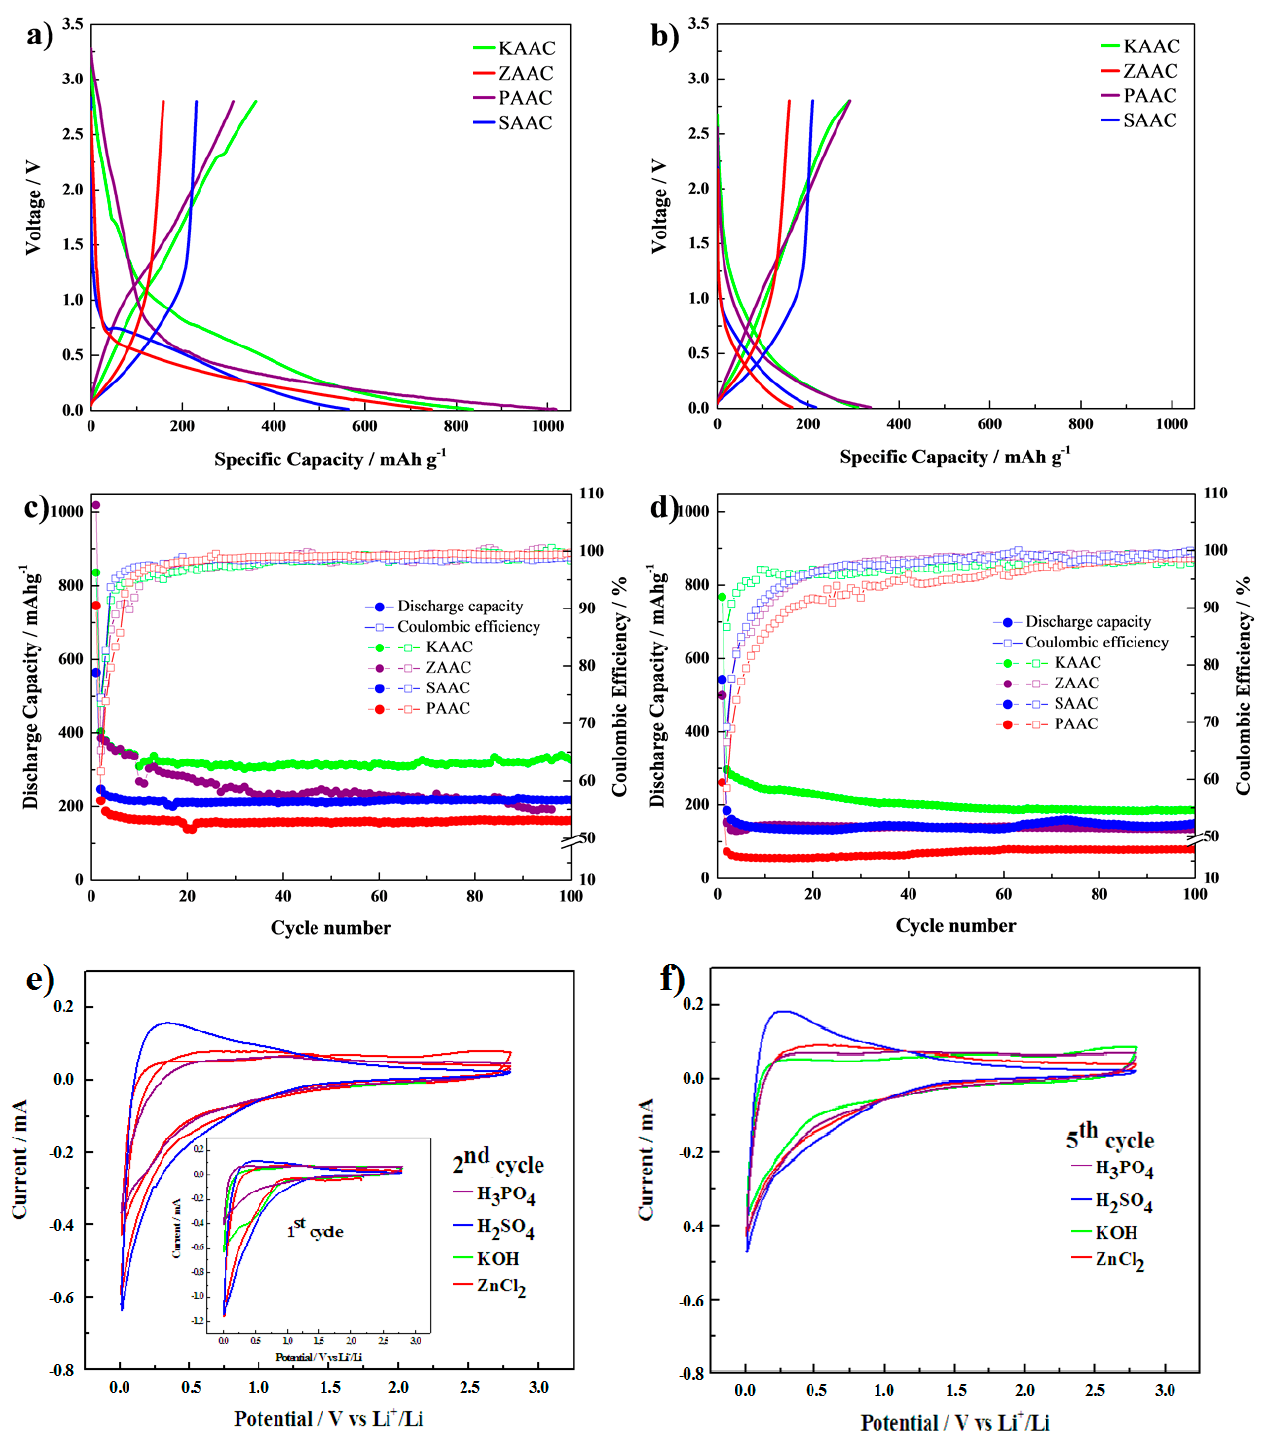
Figure 5. Cycling performances of AC electrodes ( a ) at 1st cycle at 0.1 C rate; ( b ) at 10th cycle at 0.1 C rate. Cycling performance with Coulombic efficiency (right Y -axis) of PAAC, SAAC, KAAC, and ZAAC cycled at ( c ) 0.1 C rate; ( d ) 1 C rate. CV profiles of PAAC, SAAC, KAAC, and ZAAC at a scan rate of 0.1 mV s − 1 , from 0.01 to 2.8 V: ( e ) 2nd cycle and ( f ) 5th cycle.